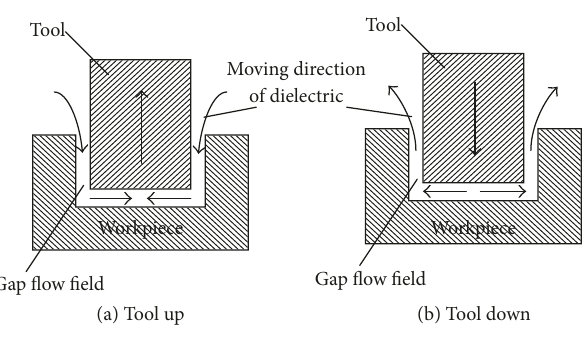
Figure 1: Schematics of tool movement